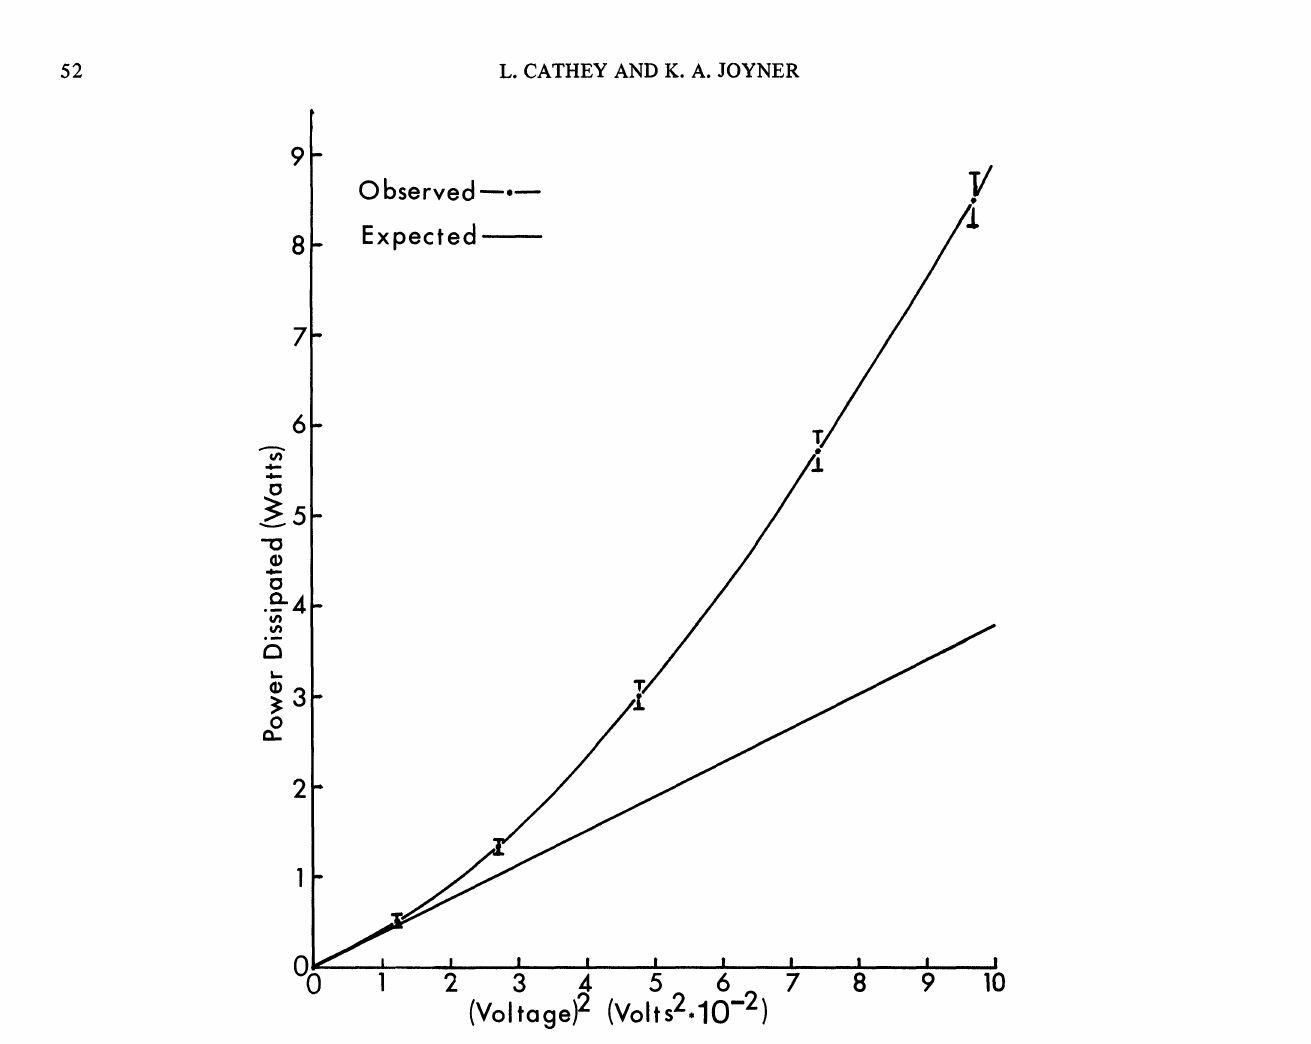
Measured values of power dissipated (o) versus the square of the peak charging voltage along with the expected dissipation based on the initial slope, which would correspond to a prediction based on specified